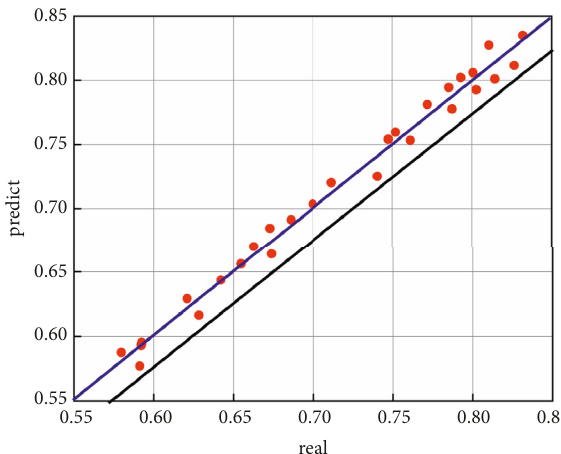
Figure 7: Predictive linear correlation coefficients of musical ex- pression effect features.